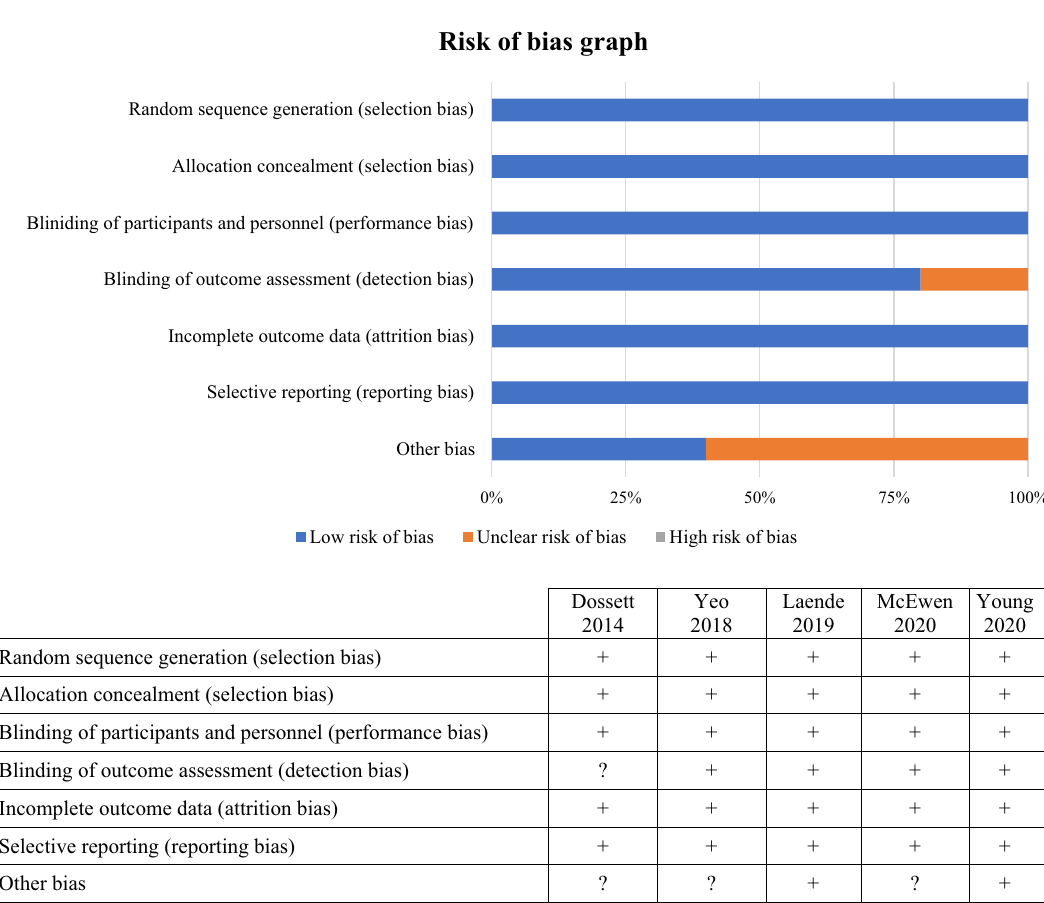
Figure 2. Risk of bias graph; “ + or plus ” indicates a low risk of bias; “ (cid:1) or minus ” indicates a high risk of bias; and “ ? or question mark ” indicates unclear of unknown risk of bias.